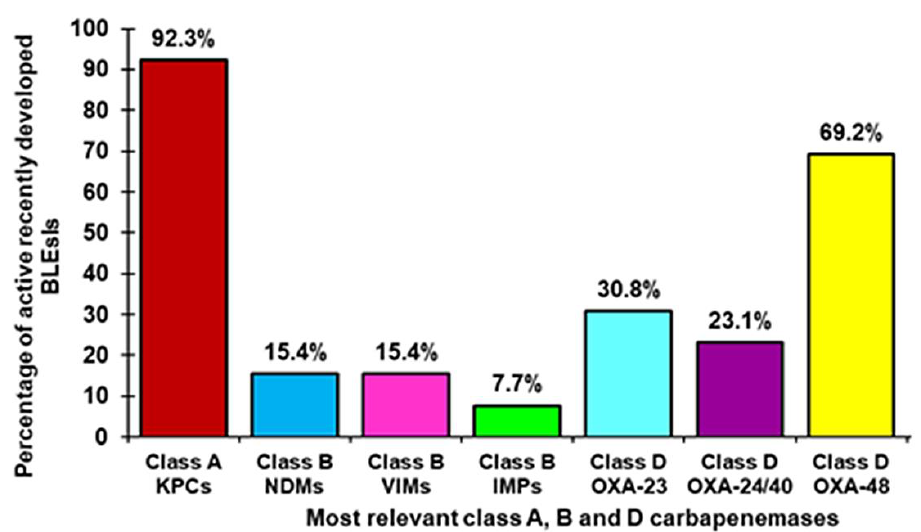
Figure 9. Percentages of all developed BLEsIs active on the different classes of BLEs.